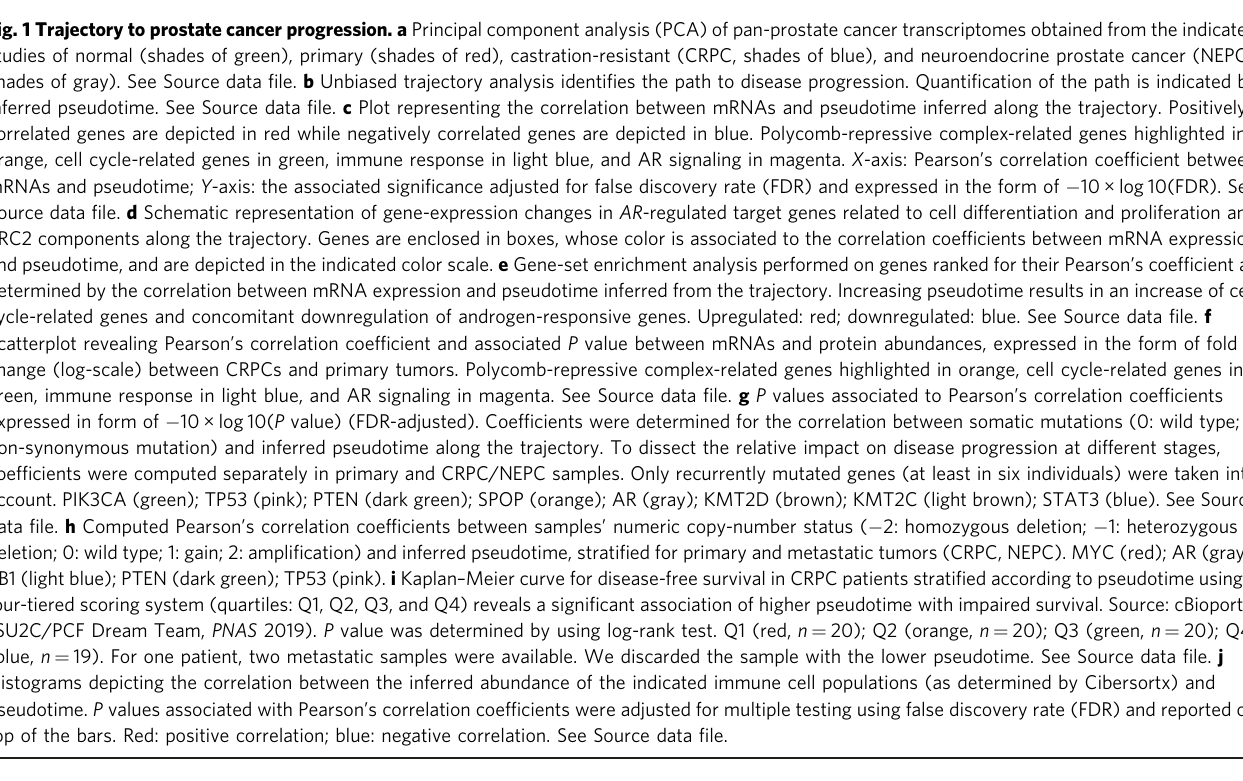
Fig. 1 Trajectory to prostate cancer progression. a Principal component analysis (PCA) of pan-prostate cancer transcriptomes obtained from the indicated studies of normal (shades of green), primary (shades of red), castration-resistant (CRPC, shades of blue), and neuroendocrine prostate cancer (NEPC, shades of gray). See Source data fi le. b Unbiased trajectory analysis identi fi es the path to disease progression. Quanti fi cation of the path is indicated by inferred pseudotime. See Source data fi le. c Plot representing the correlation between mRNAs and pseudotime inferred along the trajectory. Positively correlated genes are depicted in red while negatively correlated genes are depicted in blue. Polycomb-repressive complex-related genes highlighted in orange, cell cycle-related genes in green, immune response in light blue, and AR signaling in magenta. X -axis: Pearson ’ s correlation coef fi cient between mRNAs and pseudotime; Y -axis: the associated signi fi cance adjusted for false discovery rate (FDR) and expressed in the form of − 10 × log 10(FDR). See Source data fi le. d Schematic representation of gene-expression changes in AR -regulated target genes related to cell differentiation and proliferation and PRC2 components along the trajectory. Genes are enclosed in boxes, whose color is associated to the correlation coef fi cients between mRNA expression and pseudotime, and are depicted in the indicated color scale. e Gene-set enrichment analysis performed on genes ranked for their Pearson ’ s coef fi cient as determined by the correlation between mRNA expression and pseudotime inferred from the trajectory. Increasing pseudotime results in an increase of cell cycle-related genes and concomitant downregulation of androgen-responsive genes. Upregulated: red; downregulated: blue. See Source data fi le. f Scatterplot revealing Pearson ’ s correlation coef fi cient and associated P value between mRNAs and protein abundances, expressed in the form of fold change (log-scale) between CRPCs and primary tumors. Polycomb-repressive complex-related genes highlighted in orange, cell cycle-related genes in green, immune response in light blue, and AR signaling in magenta. See Source data fi le. g P values associated to Pearson ’ s correlation coef fi cients expressed in form of − 10 × log 10( P value) (FDR-adjusted). Coef fi cients were determined for the correlation between somatic mutations (0: wild type; 1: non-synonymous mutation) and inferred pseudotime along the trajectory. To dissect the relative impact on disease progression at different stages, coef fi cients were computed separately in primary and CRPC/NEPC samples. Only recurrently mutated genes (at least in six individuals) were taken into account. PIK3CA (green); TP53 (pink); PTEN (dark green); SPOP (orange); AR (gray); KMT2D (brown); KMT2C (light brown); STAT3 (blue). See Source data fi le. h Computed Pearson ’ s correlation coef fi cients between samples ’ numeric copy-number status ( − 2: homozygous deletion; − 1: heterozygous deletion; 0: wild type; 1: gain; 2: ampli fi cation) and inferred pseudotime, strati fi ed for primary and metastatic tumors (CRPC, NEPC). MYC (red); AR (gray); RB1 (light blue); PTEN (dark green); TP53 (pink). i Kaplan – Meier curve for disease-free survival in CRPC patients strati fi ed according to pseudotime using a four-tiered scoring system (quartiles: Q1, Q2, Q3, and Q4) reveals a signi fi cant association of higher pseudotime with impaired survival. Source: cBioportal (SU2C/PCF Dream Team, PNAS 2019). P value was determined by using log-rank test. Q1 (red, n = 20); Q2 (orange, n = 20); Q3 (green, n = 20); Q4 (blue, n = 19). For one patient, two metastatic samples were available. We discarded the sample with the lower pseudotime. See Source data fi le. j Histograms depicting the correlation between the inferred abundance of the indicated immune cell populations (as determined by Cibersortx) and pseudotime. P values associated with Pearson ’ s correlation coef fi cients were adjusted for multiple testing using false discovery rate (FDR) and reported on top of the bars. Red: positive correlation; blue: negative correlation. See Source data fi